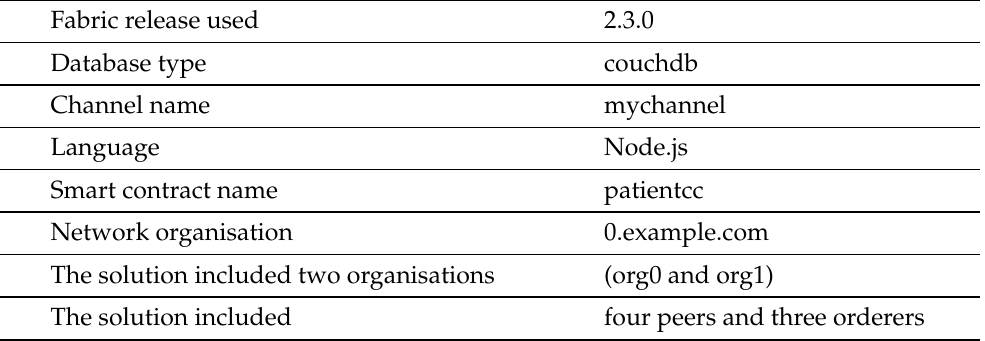
Table 7. Installation